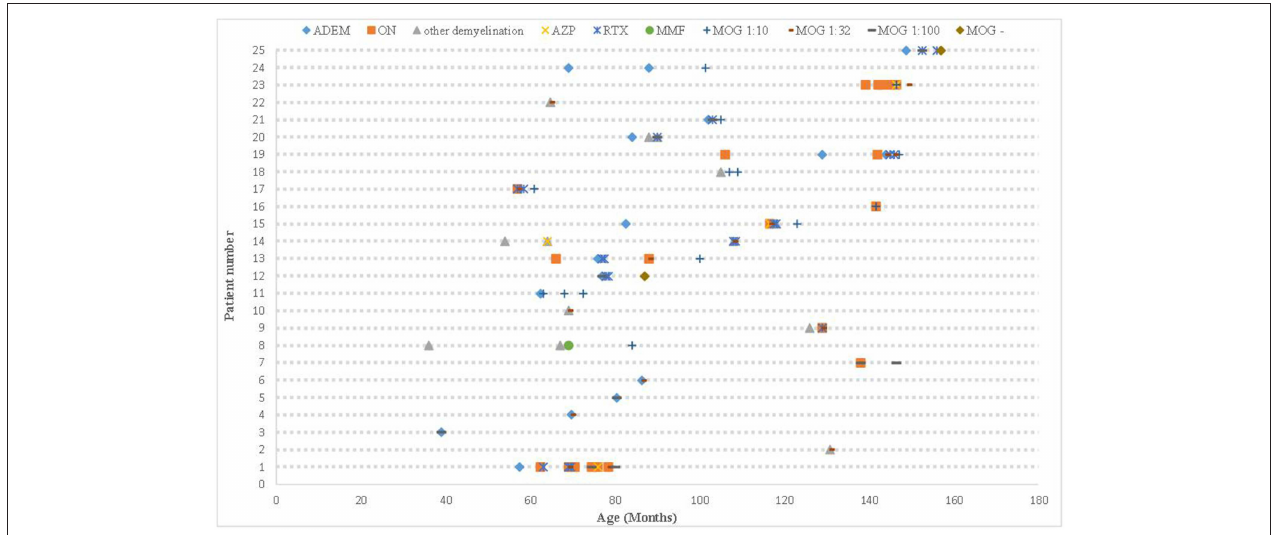
FIGURE 2 | The clinical course, MOG-Ab titers, and DMDs of all patients. ADEM, acute disseminated encephalomyelitis; AZP, azathioprine; DMDs, disease-modifying drugs; MOG-Ab, myelin oligodendrocyte glycoprotein antibody; MMF, mycophenolate mofetil; ON, optic neuritis; RTX, rituximab.